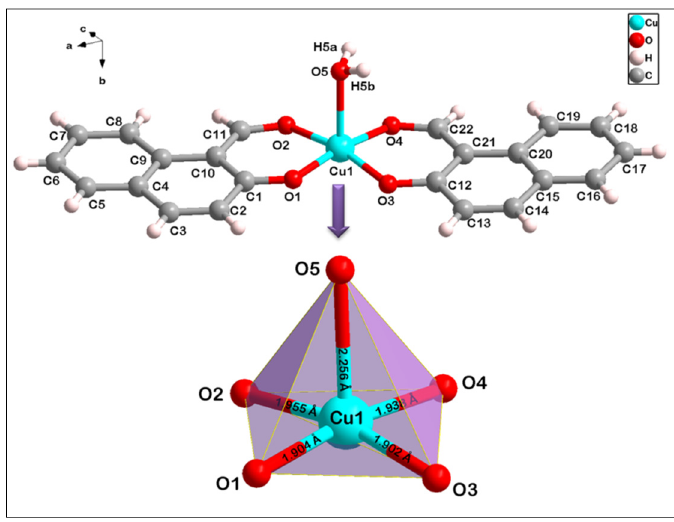
Figure 1. Molecular representation of the asymmetric units of complex 1.